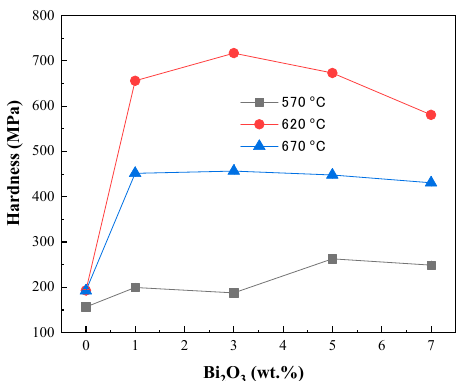
Figure 3. Hardness versus sintering temperature of PbO ceramic pellets with different wt.% of Bi 2 O 3 .